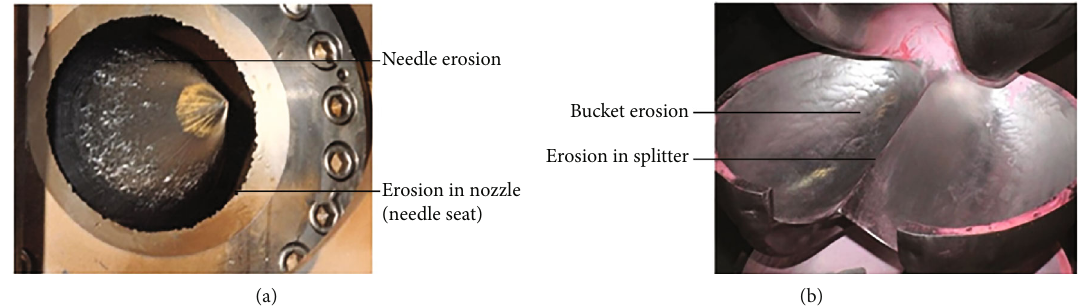
Figure 1: Typical erosion in Pelton turbine parts: (a) Mel Norway [18] and (b) bucket of Khimti Powerplant, Nepal